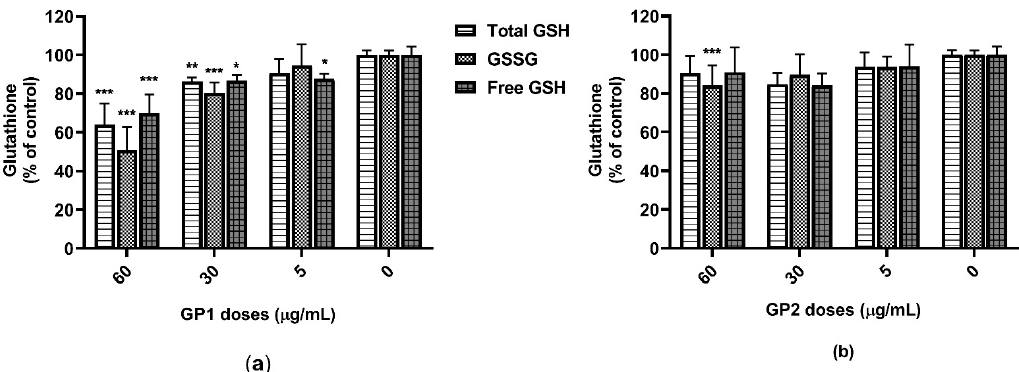
Figure 3. Glutathione content in THP-1 lysates after 40 h of exposure to GP: ( a ) content of total glutathione (GSH), oxidized glutathione (GSSG) and free GSH after exposure to GP1; ( b ) content of total GSH, GSSG and free GSH after exposure to GP2. Data are presented as a percentage (%) of untreated control (0 µg/mL) and are visualized as mean ± standard deviation. * p -value < 0.05; ** p -value < 0.01; *** p -value < 0.001.